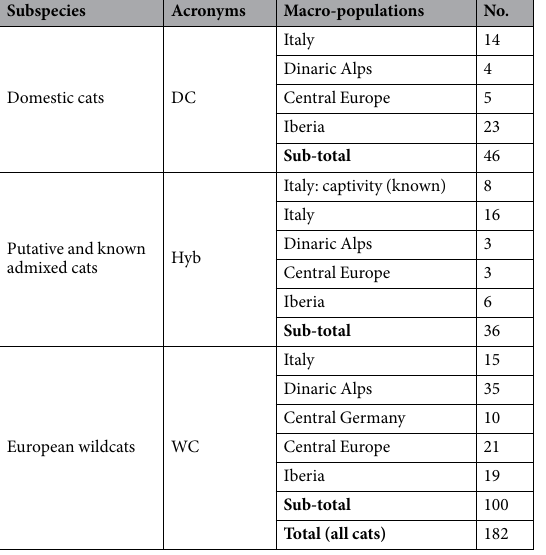
Table 3. Origin and sample size of the genotyped domestic cats ( Felis silvestris catus ), European wildcats ( F . s . silvestris ) and their putative admixed cats. All cats were preliminarily assigned to their most likely subspecies/ macro-population of origin by Bayesian clustering and admixture analyses performed in Mattucci et al . 27